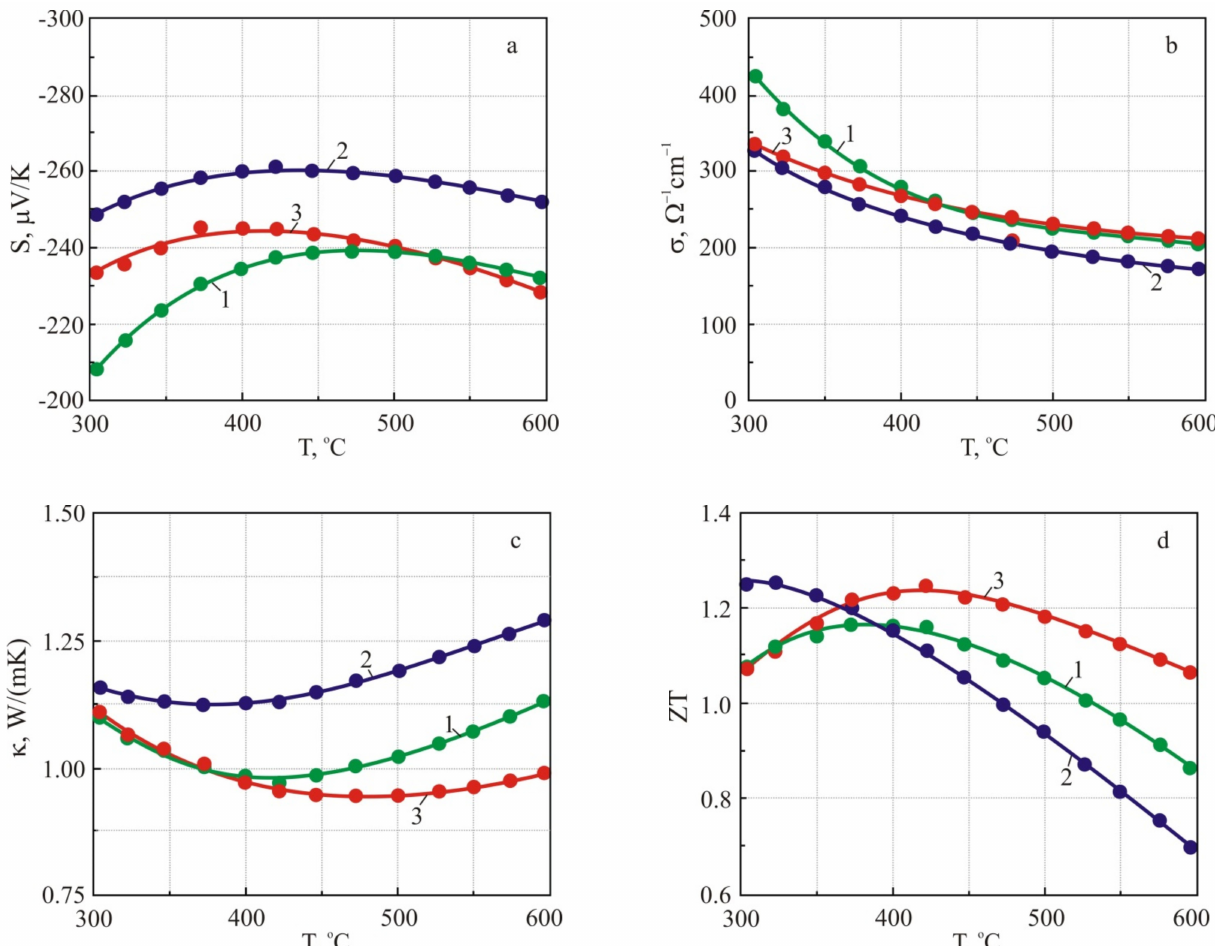
Figure 10. The temperature dependence of Seebeck coefficient ( a ), electrical conductivity ( b ), thermal conductivity ( c ), and the dimensionless figure of merit ZT ( d ) over 300–600 ◦ C temperature range for n -type Pb 1 − x In x Te 1 − y I y fabricated by SPS. 1—Pb 1 Te 0.999 I 0.001 . 2—Pb 0.9995 In 0.0005 Te 0.9995 I 0.0005 . 3—Pb 0.999 In 0.001 Te 0.999 I 0.001